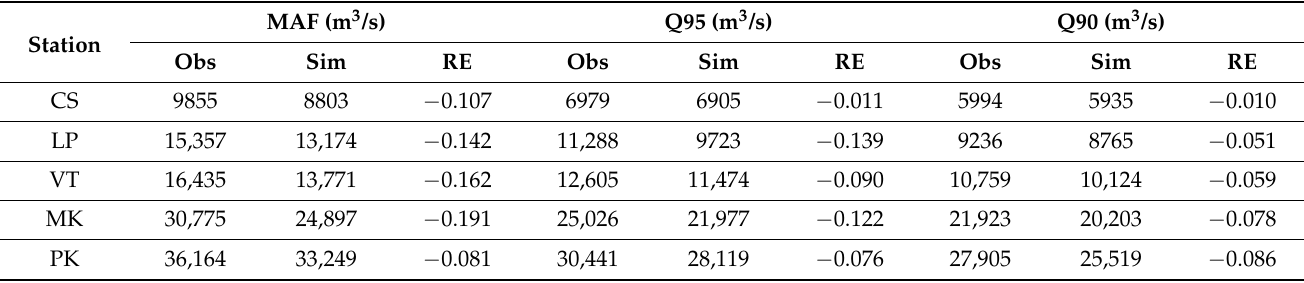
Table 3. Flood indicators performance of HPD model for testing period